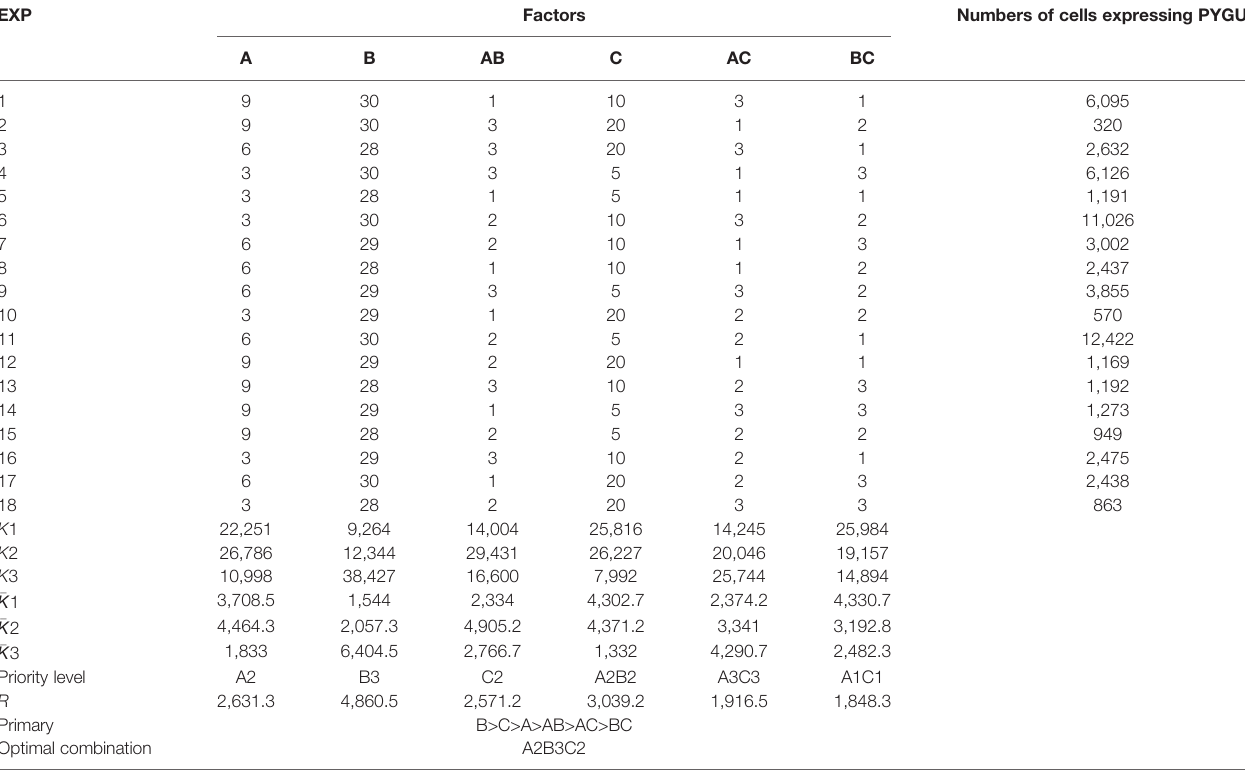
TABLE 1 | Orthogonal test design and results. EXP